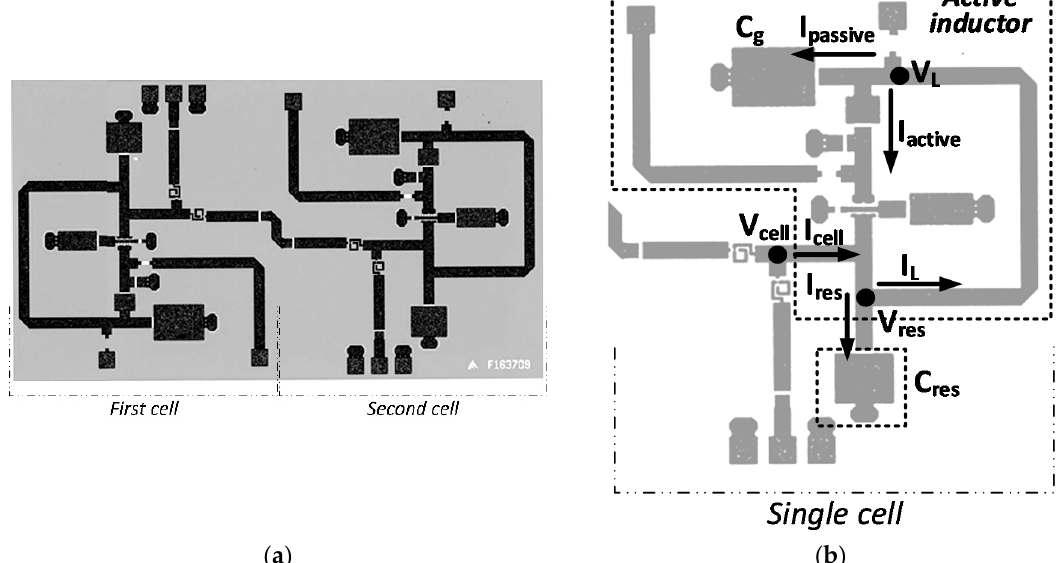
Figure 10. The fabricated active filter: ( a ) Photograph of the chip, ( b ) a single cell where the currents of Figure 4 are indicated.